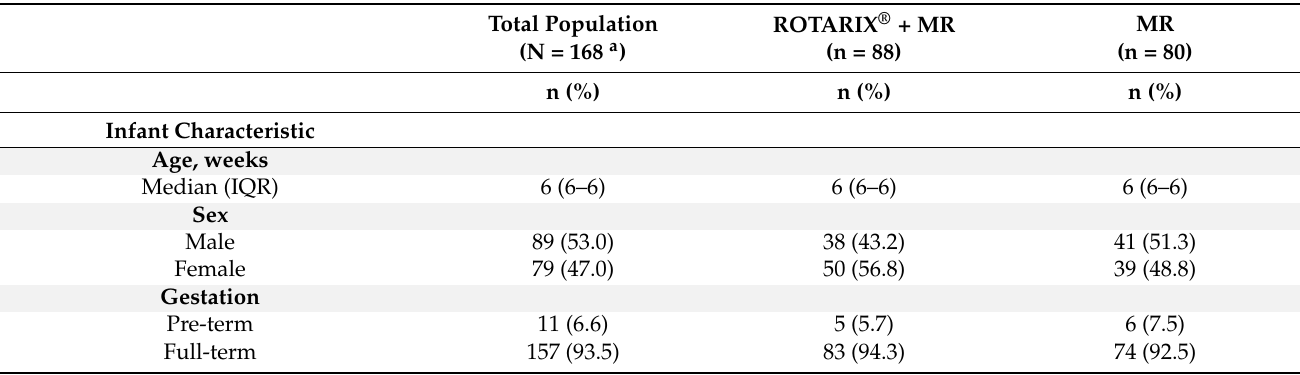
Table 1. Baseline characteristics of mother/infant pairs by trial